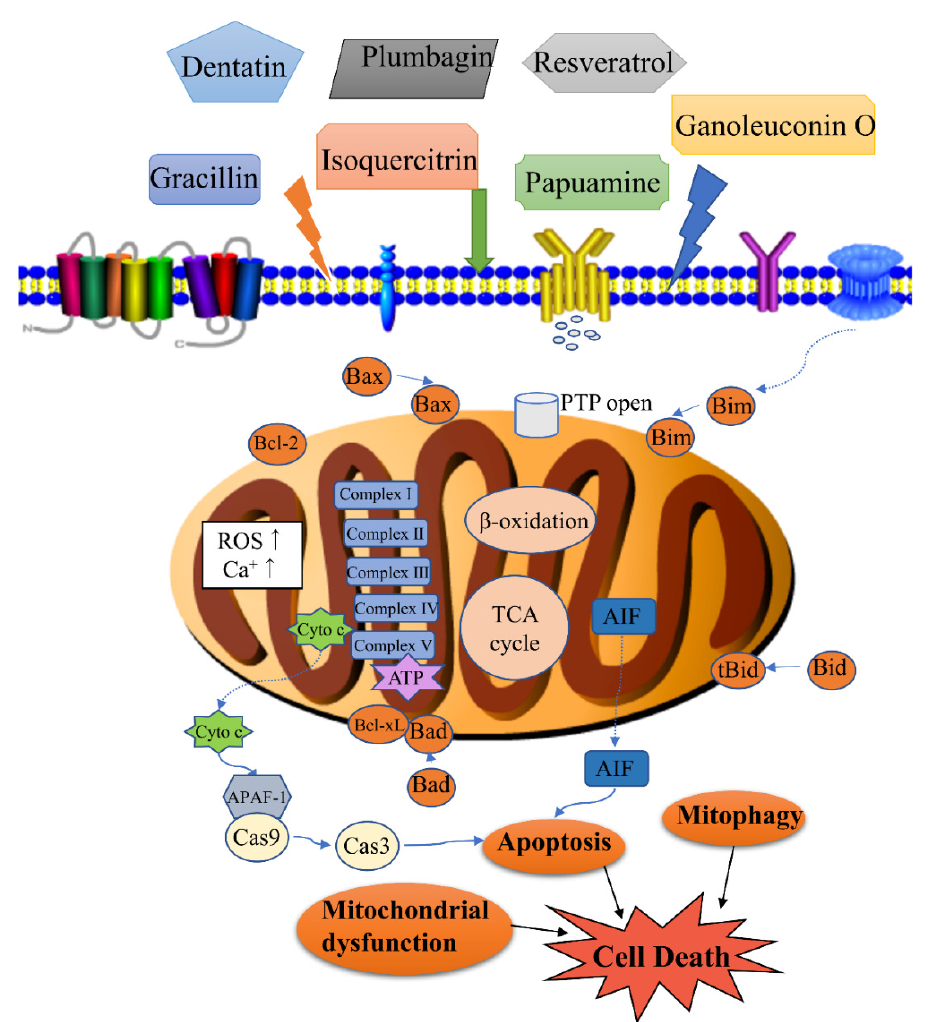
Figure 1. Modulation of mitochondrial-related cell death by natural products. Cell death associated with the activity of natural products includes apoptosis, mitophagy, mitochondrial dysfunction, etc. Apoptosis is regulated by the levels of Bcl-2 (B-cell lymphoma-2) family proteins, release of cytochrome c, and caspase activation. Mitophagy is the targeted phagocytosis and destruction of mitochondria by the autophagy machinery, and it is generally considered as the main mechanism of mitochondrial quality control. A decrease in energy production, an increase of reactive oxygen species (ROS) and permeability transition pore (PTP) opening can lead to mitochondrial